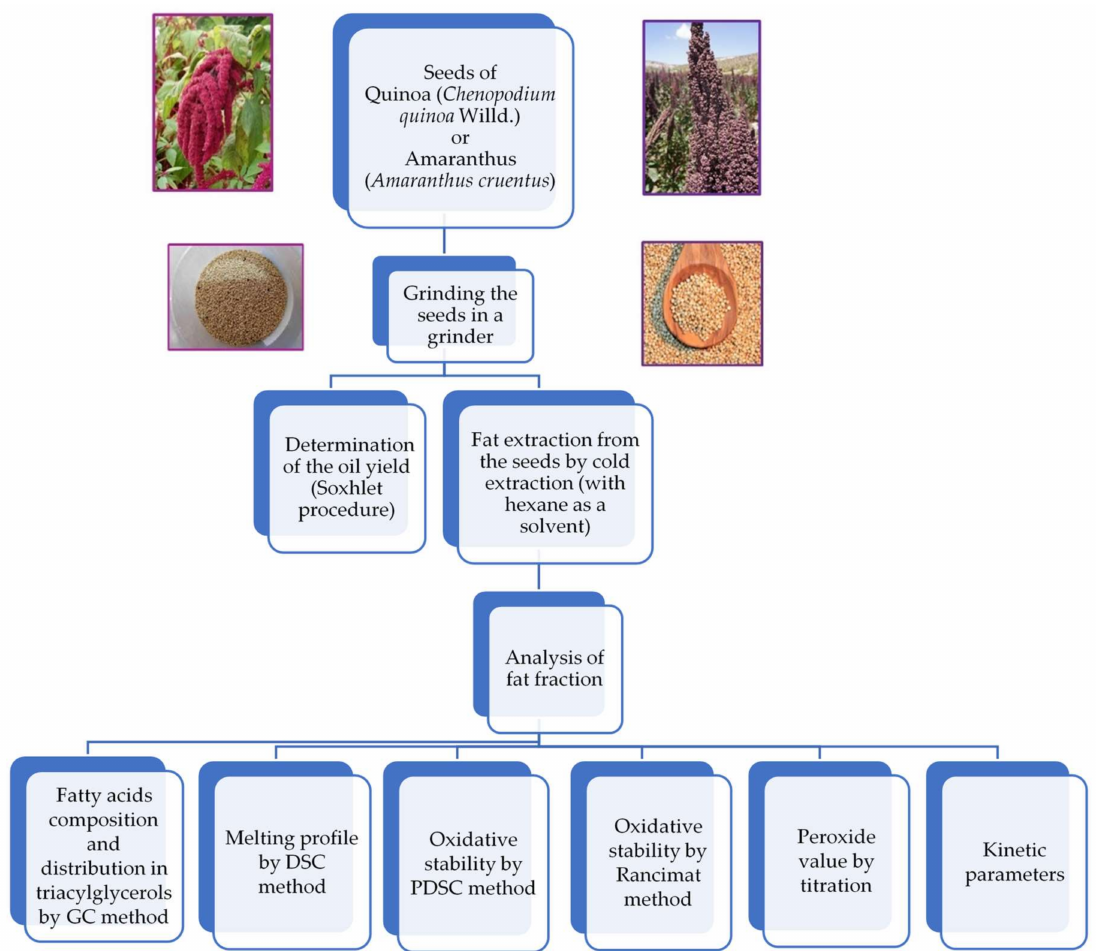
Figure 1. Graphical scheme of study approach (GC method—gas chromatography